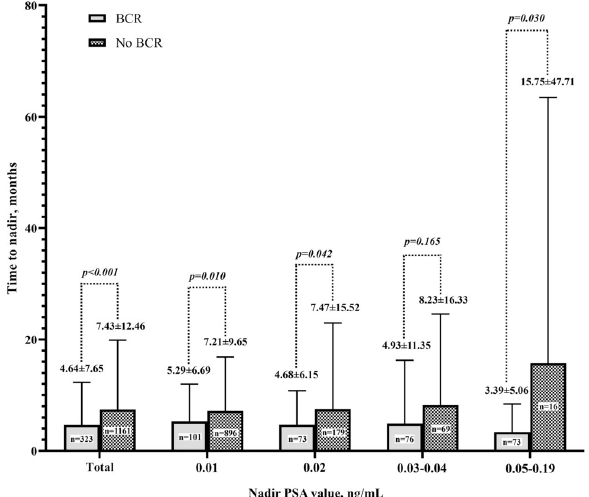
Fig 2. Comparison of time to nadir of biochemical recurrence (BCR) group versus no-recurrence groups using Student’s t-test.